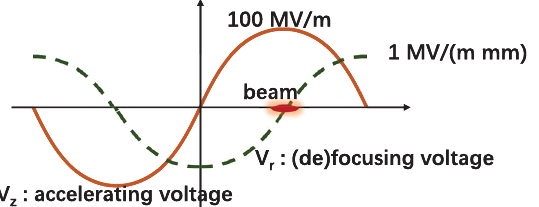
FIG. 19. Off-axis distribution of transverse deflection strength [MV = m] to the beam: (a) G